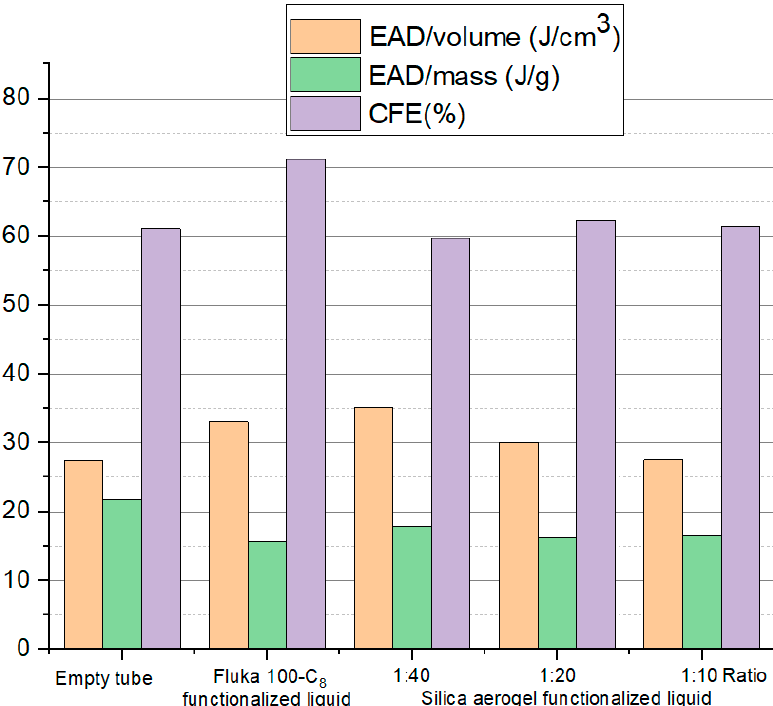
Figure 10. Simulated energy-absorption capabilities of different solid/liquid ratios